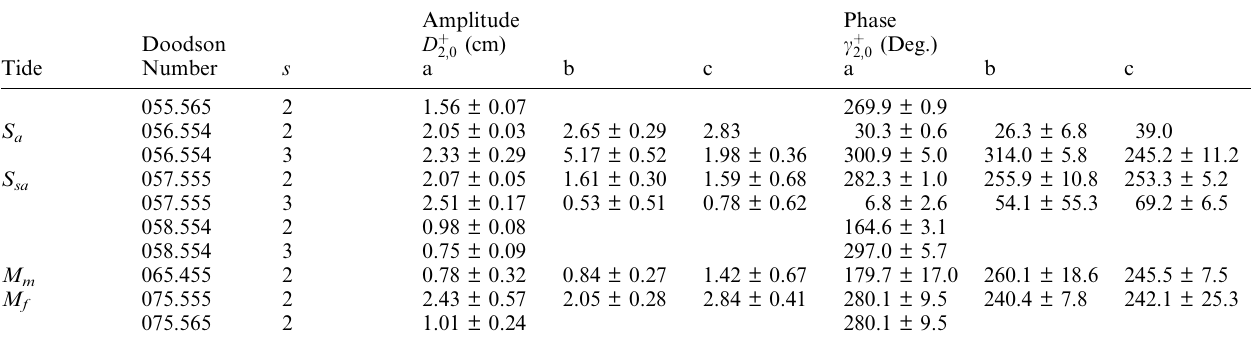
Table 1. Long-period ocean-tide parameters from the final fitting (a (cid:136) this analysis, b (cid:136) GEM-T3, c (cid:136) Cheng)